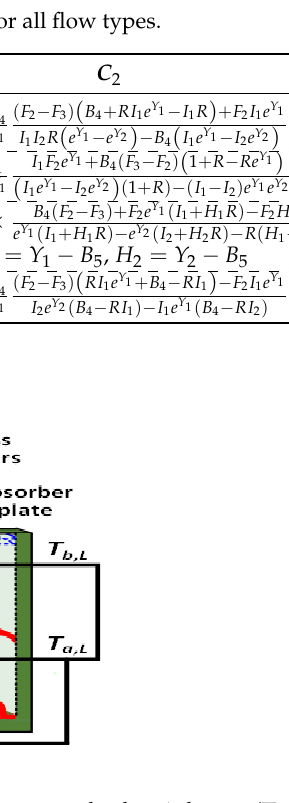
Figure 4. Schematic drawing of a recycling double-pass cross-corrugated solar air heater ( Type B ).